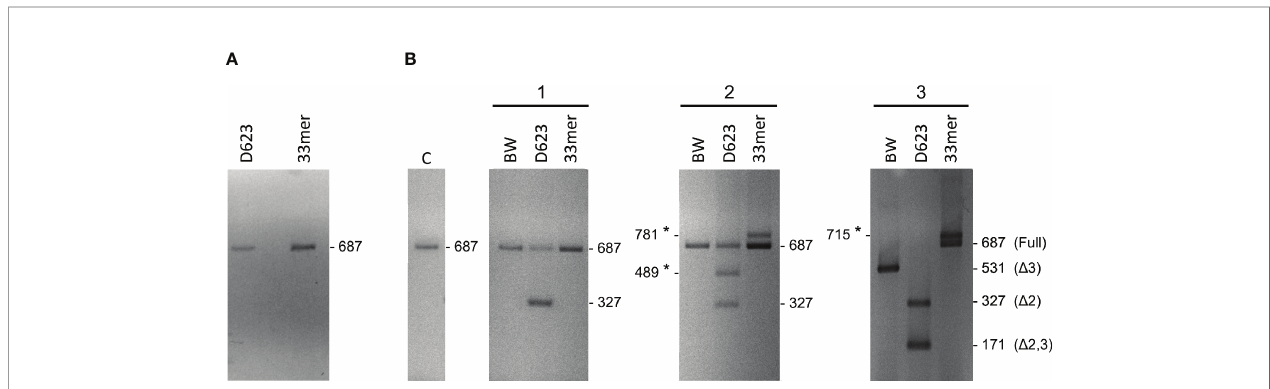
FIGURE 8 | Gel electrophoresis of PD-1 cDNA ampli fi cation products from PBMCs stimulated with gluten peptides in healthy controls (A) and in celiac patients (B) . With the used primers in the present study, the sizes of the respective PCR products were 687 bp for the full-length PD-1 transcript, 531 bp for PD-1Dex3, 327 bp for PD-1Dex2, 171 bp for PD-1Dex2,3, and three new isoforms with 781, 715, and 489 bp. Asterisks indicate the new isoforms found in this study.